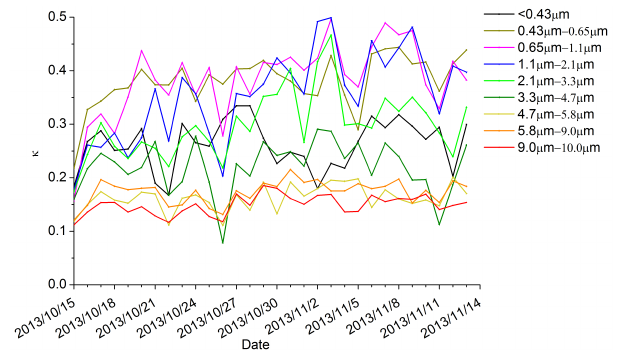
Figure 4. Time series of κ in different size segments during the observation period.